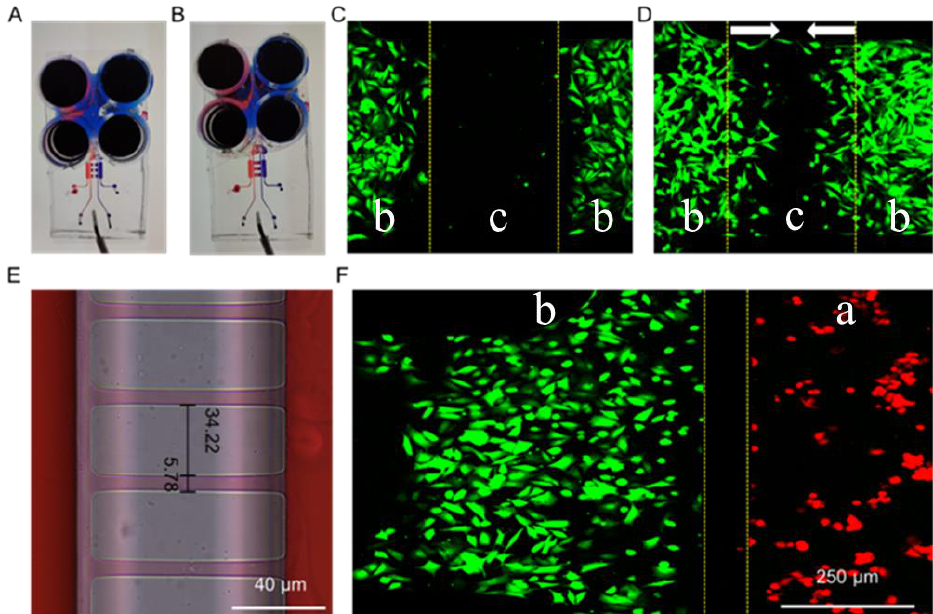
Figure 2. Images of the microfluidic chip with the air valve closed ( A ) and opened ( B ). Fluorescence images of NIH-3T3 cells on the microfluidic chip before ( C ) and after ( D ) valve opened. ( E ) Image of the microchannels connecting part a and part b of the microfluidic chip. ( F ) Fluorescence images of NIH-3T3 (green) and RAW264.7 (red) separated by microchannels connecting part a and part b. “a”, “b” and “c” were marked to indicate different areas of the microfluidic chip. It was consistent with Scheme 1. The arrows in ( D ) indicated the cell migration directions.